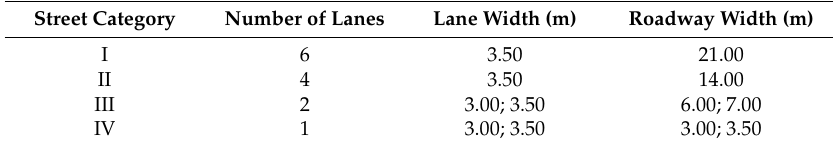
Table 3. Streets—geometrical constituents in cross-sectional profile [31,32].